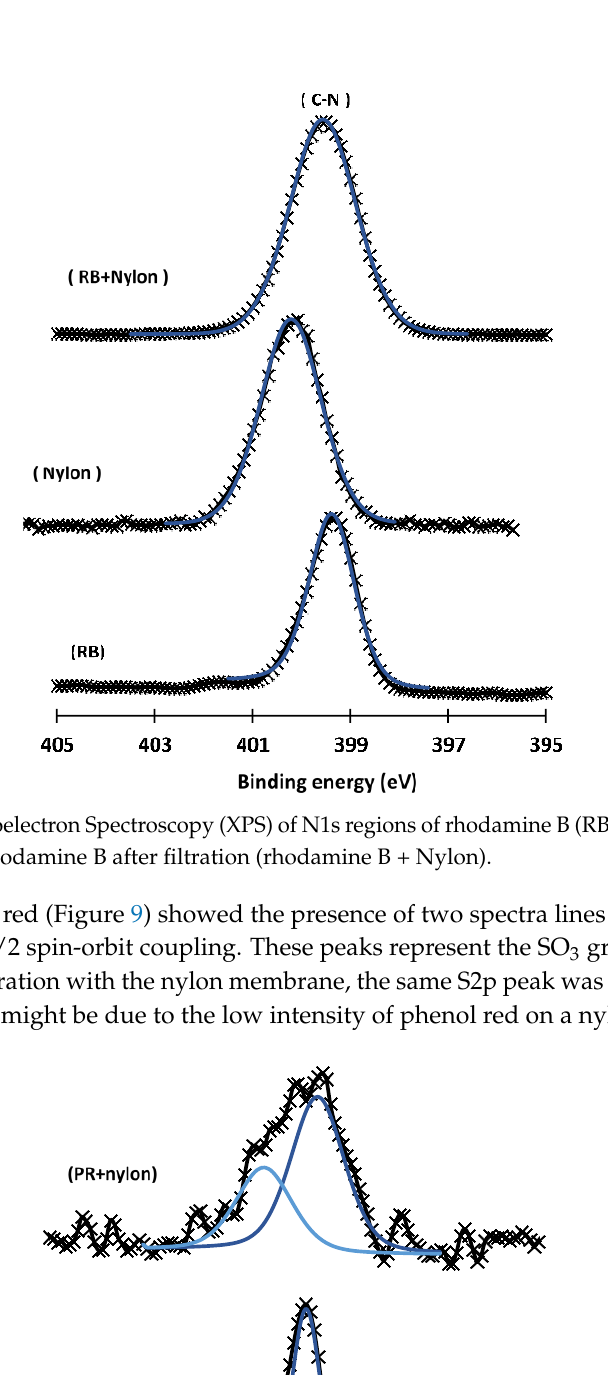
Figure 9. XPS of the S2p region of phenol red before (PR) and after filtration (phenol red + Nylon).